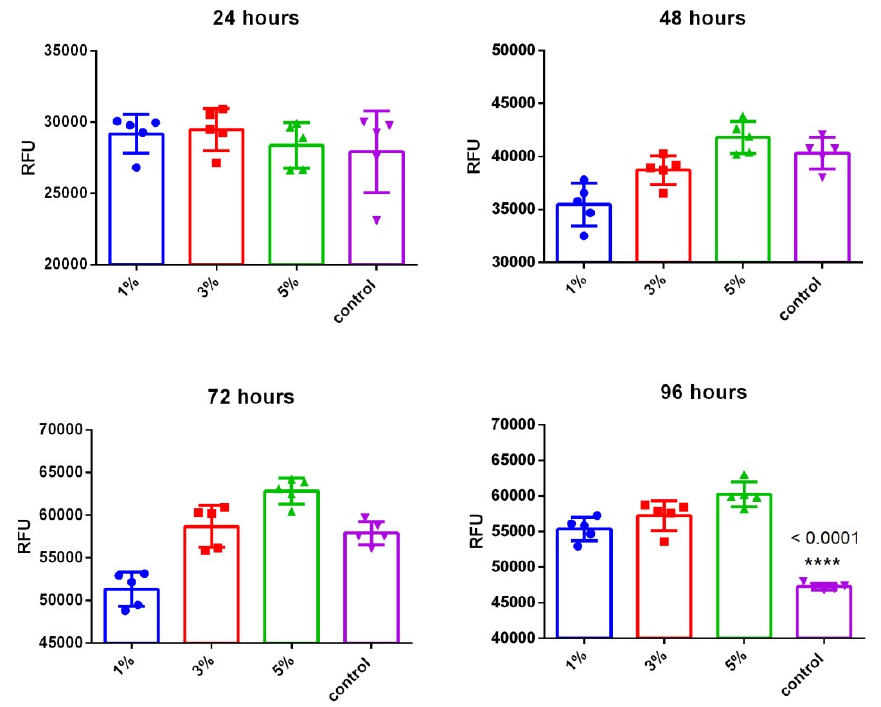
Figure 8. Viability of mouse MSC culture after cultivation on CeO 2 -containing BC scaffolds for 96 h. Data are presented as the mean value ± SD. Cover glass was used as a control. **** p < 0.0001 via control.